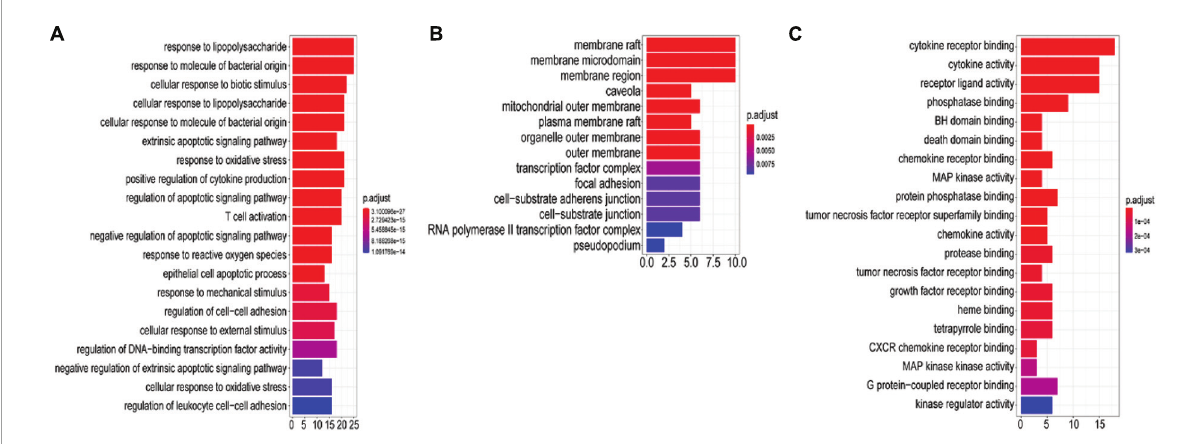
FIGURE5 GO analysis of 51 potential targets genes. The y -axis shows the name of the GO entry, and the x -axis shows the value of gene number count, the value of which represents the number of targets enriched on the GO entry. The redder the color is, the smaller the value of p. adjust is.